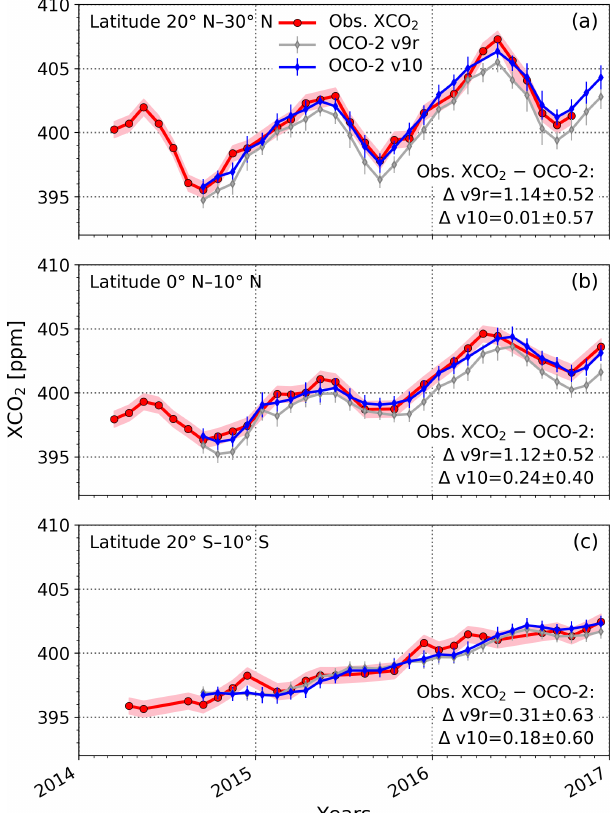
Figure A2. Comparison of the temporal variation of obs. XCO 2 (red) with XCO 2 derived from OCO-2 v9r (gray) and OCO-2 v10 (blue) for three selected latitude ranges. Red-shaded areas are the uncertainty of the obs. XCO 2 which was derived from the ± 2ppm variability in the observation-based CO 2 profile at ∼ 850hPa. Error bars show the standard deviation of the monthly averaged XCO 2